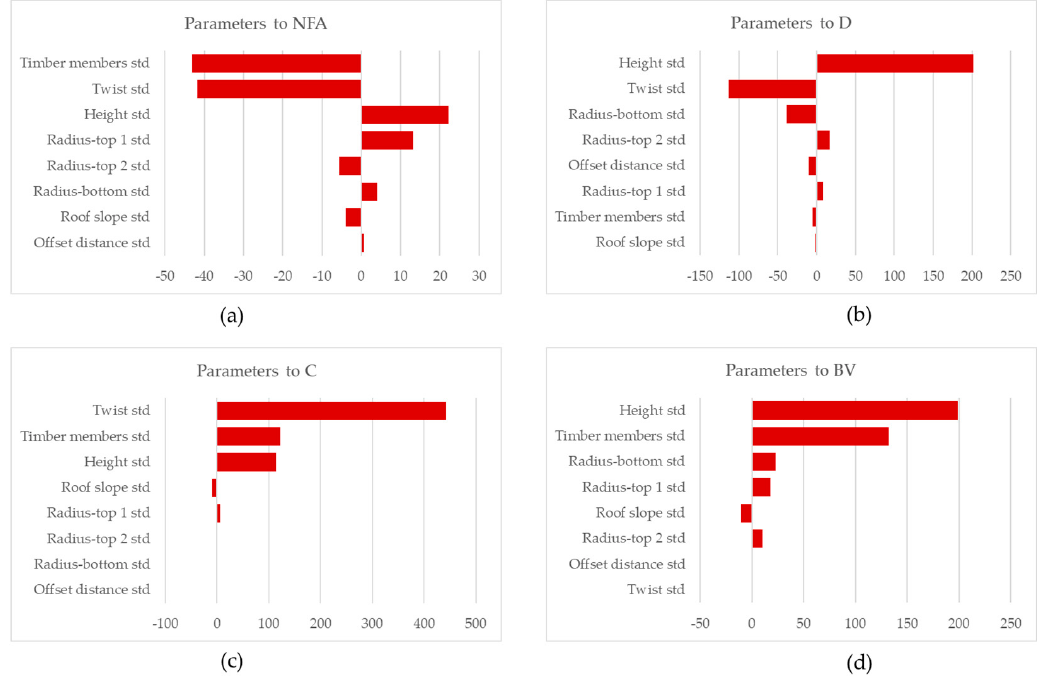
Figure 17. Sensitivity analysis showing the significant implication of each parameter toward the objective: ( a ) parameters to NFA; ( b ) parameters to D; ( c ) parameters to C; ( d ) parameters to (BV).